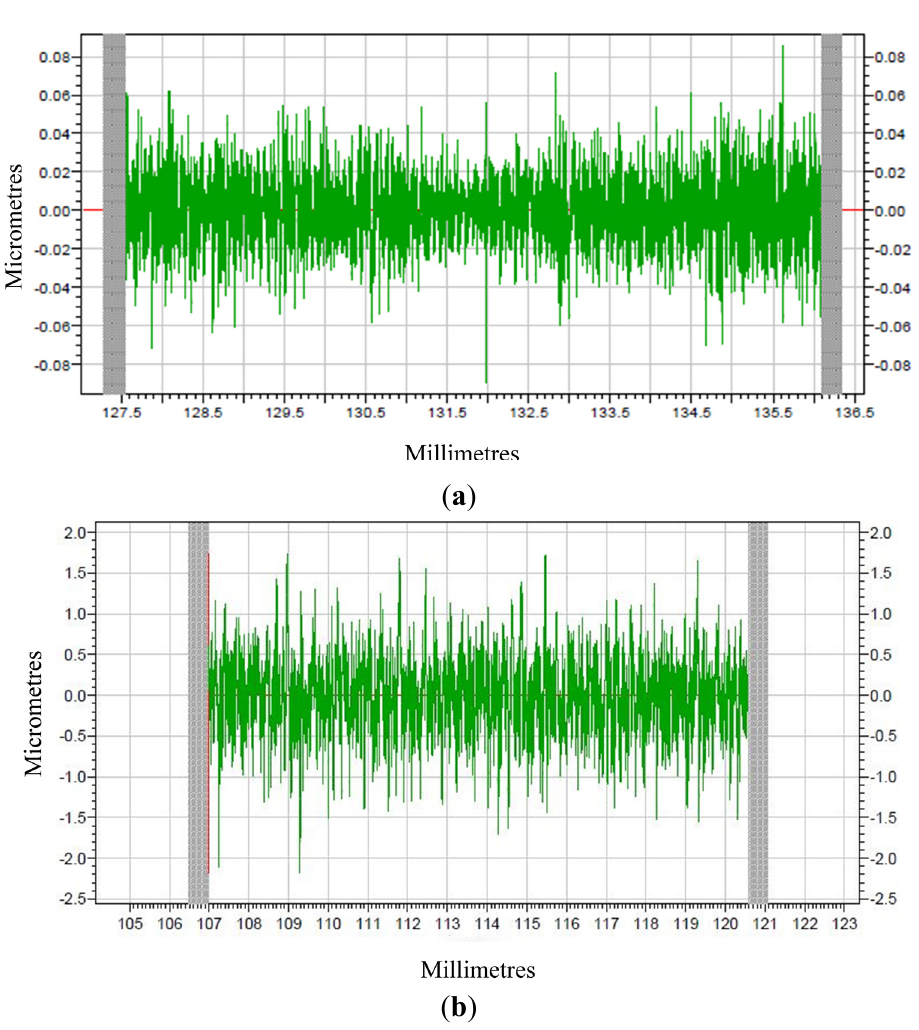
Figure 11. The surface roughness of machined surface ( a ) PEEK; ( b ) PEEK CF